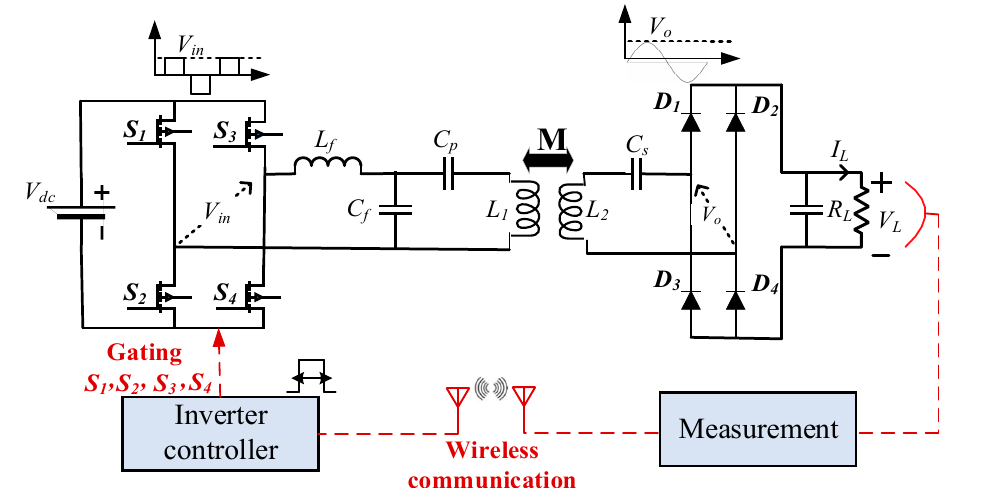
Figure 24. Transmitter-side inverter control for a WPT system. Table 11. Various transmitter-side control techniques.